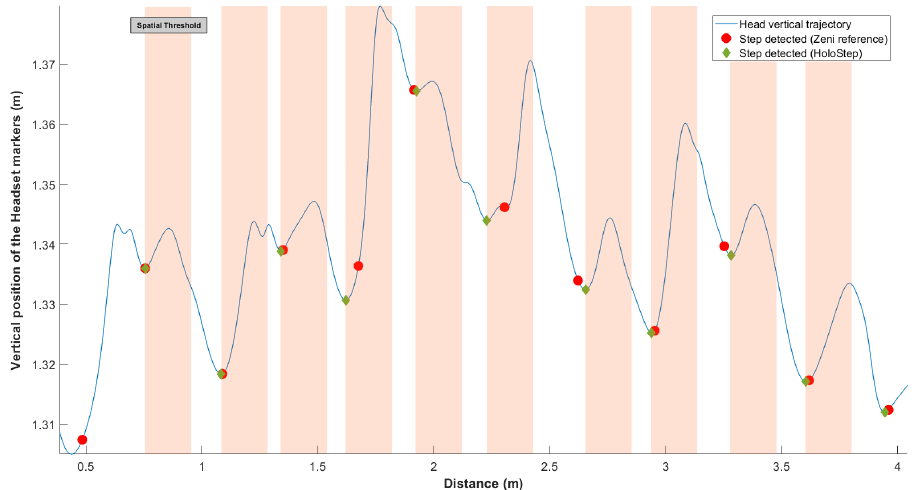
Figure 2. Representation of the locking distance threshold. In blue, vertical head position y F of the user wearing the AR HMD over the walkway. The green diamonds were IC detected with HoloStep. The red circle were IC detected with Zeni algorithm reported to y F . The orange bands were the locking distance threshold (minimum peaks ignored by